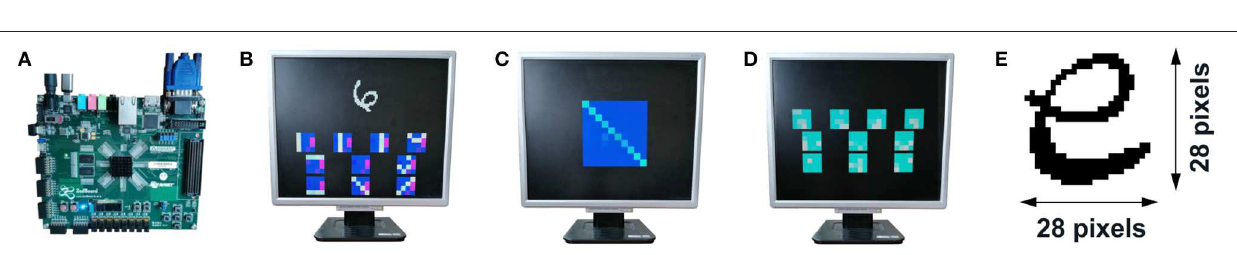
FIGURE 6 | (A) The low-cost Zedboard used for the implementation of the system. The Zedboard is connected to Matlab and to the screen. (B) Visual representation of the digital STDP learning procedure, (C) the confusion matrix for classification, and the (D) responses after convolving the input with the filters. (E) An example of a digit drawn by a user on the tabet connected to the